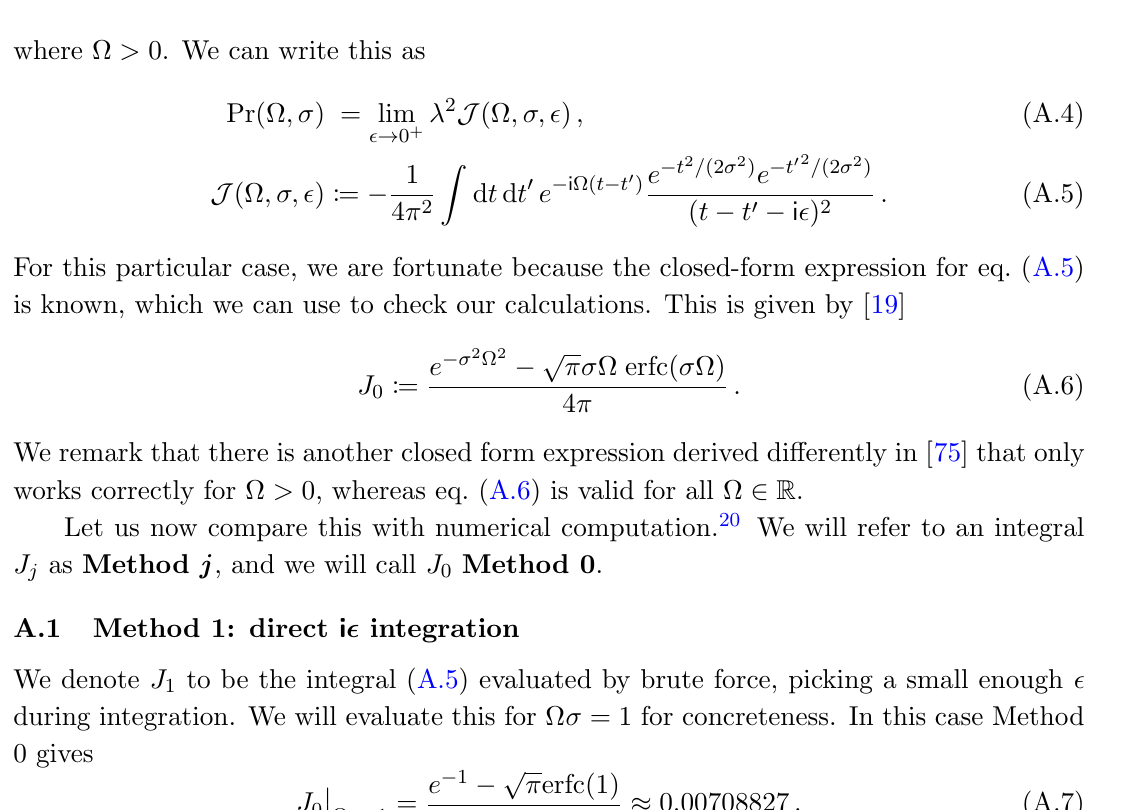
Table 1 . Values of J 1 using Method 1 (direct i (cid:15) integration) as (cid:15)